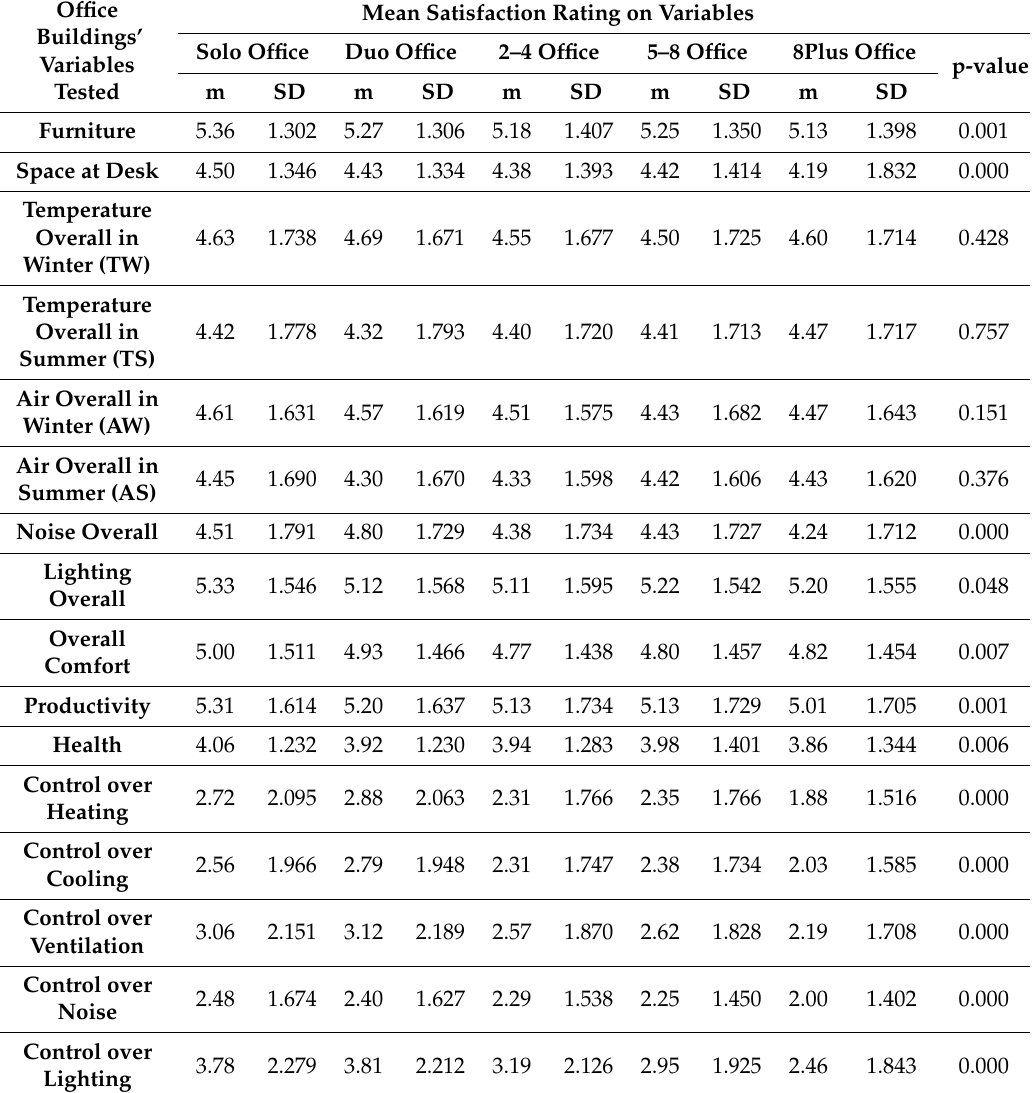
Table 2. Mean Scores of variables